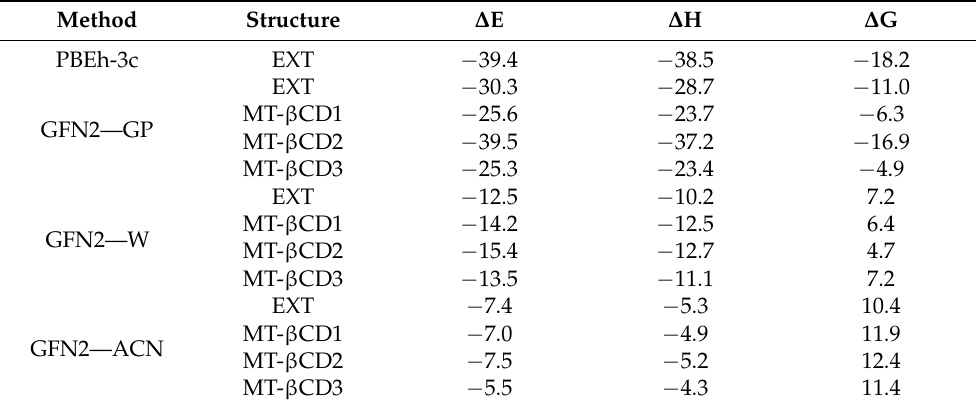
Table 5. Complexation energy ( ∆ E), enthalpy ( ∆ H) and free energy ( ∆ G). Values are in